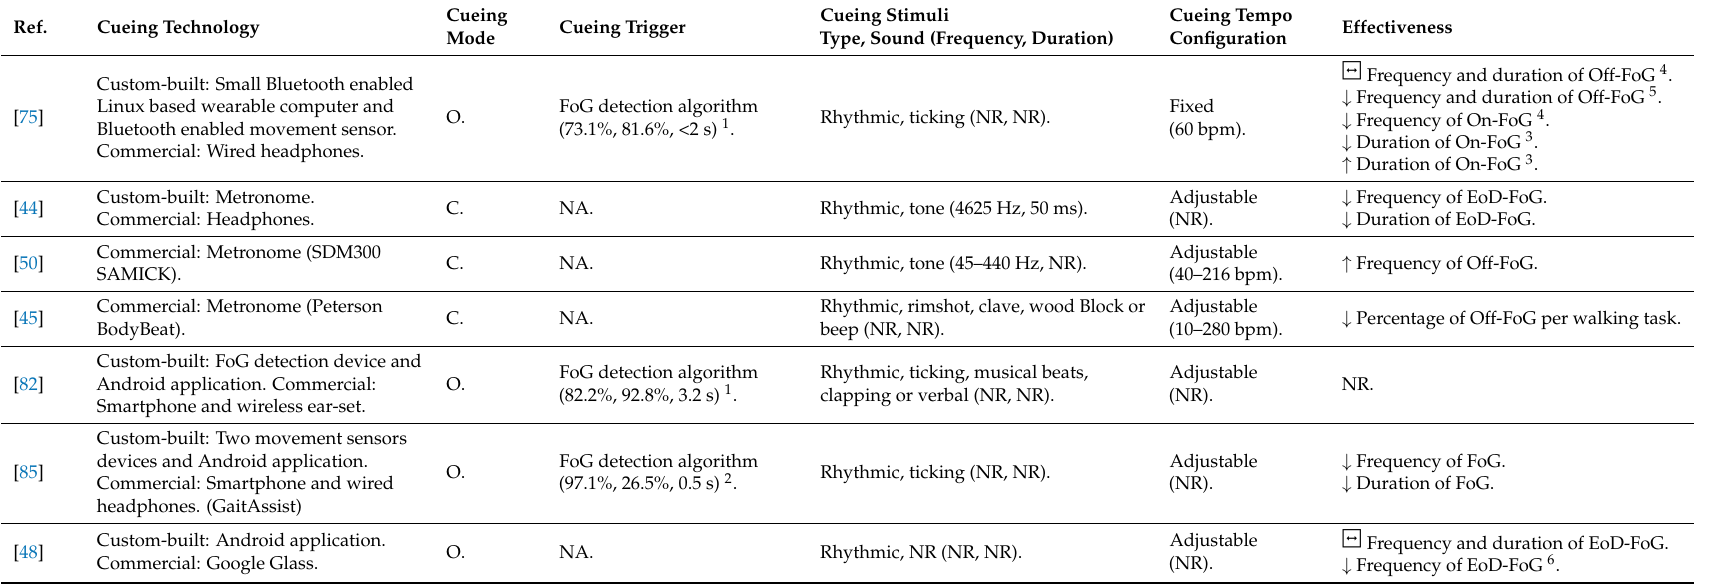
Table 2. Overview of auditory cueing devices.